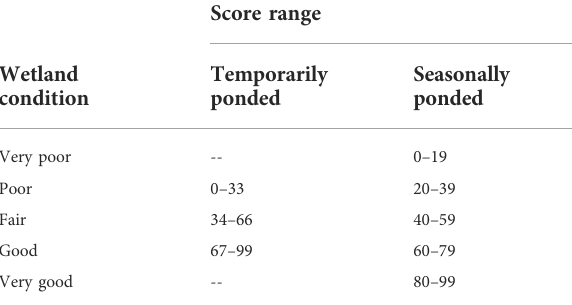
TABLE 2 Score ranges for each Index of Plant Community Integrity condition category for temporarily ponded and seasonally ponded wetlands of the Prairie Pothole Region of North America (see Hargiss et al.,